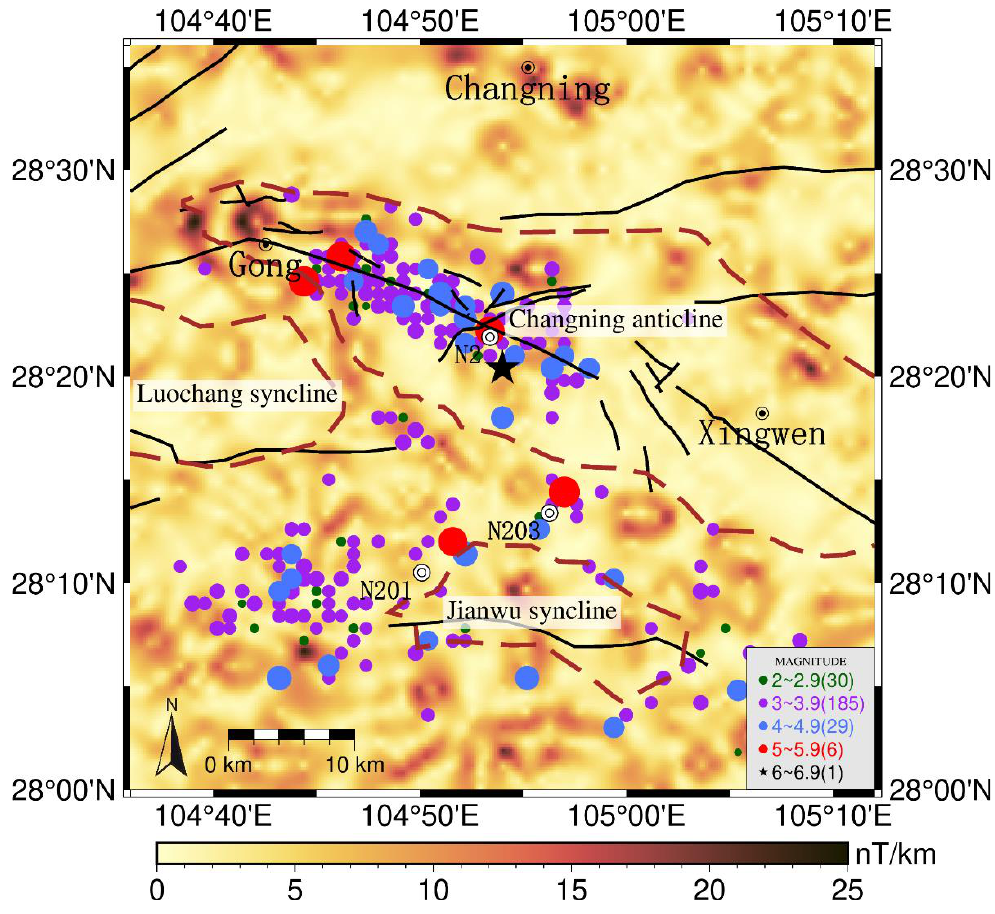
Figure 5. Total intensity gradients of magnetic anomalies in the Changning area.